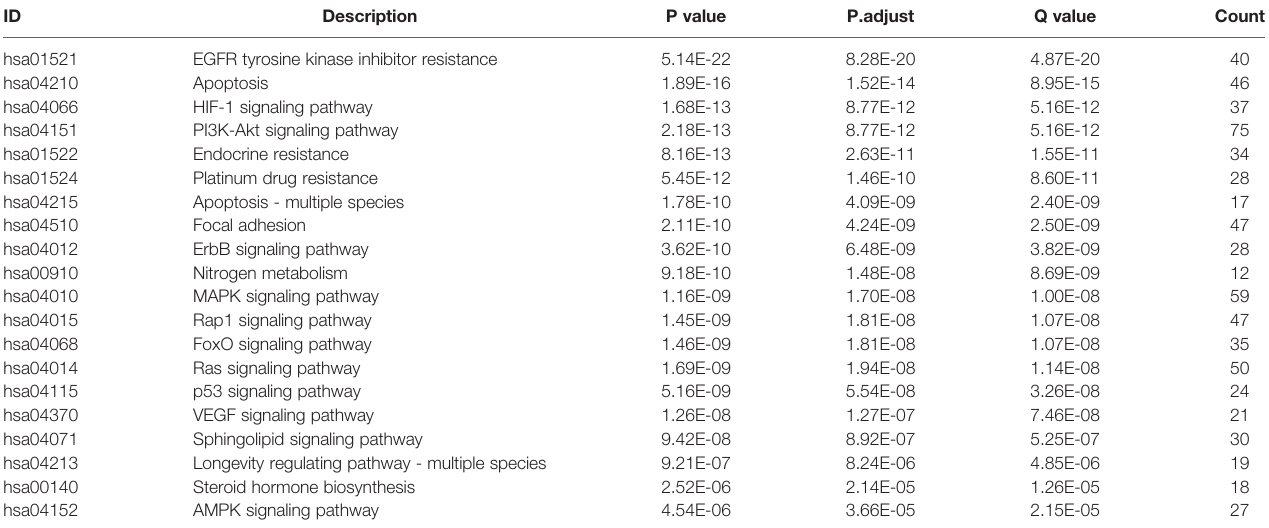
TABLE 4 | KEGG pathway enrichment